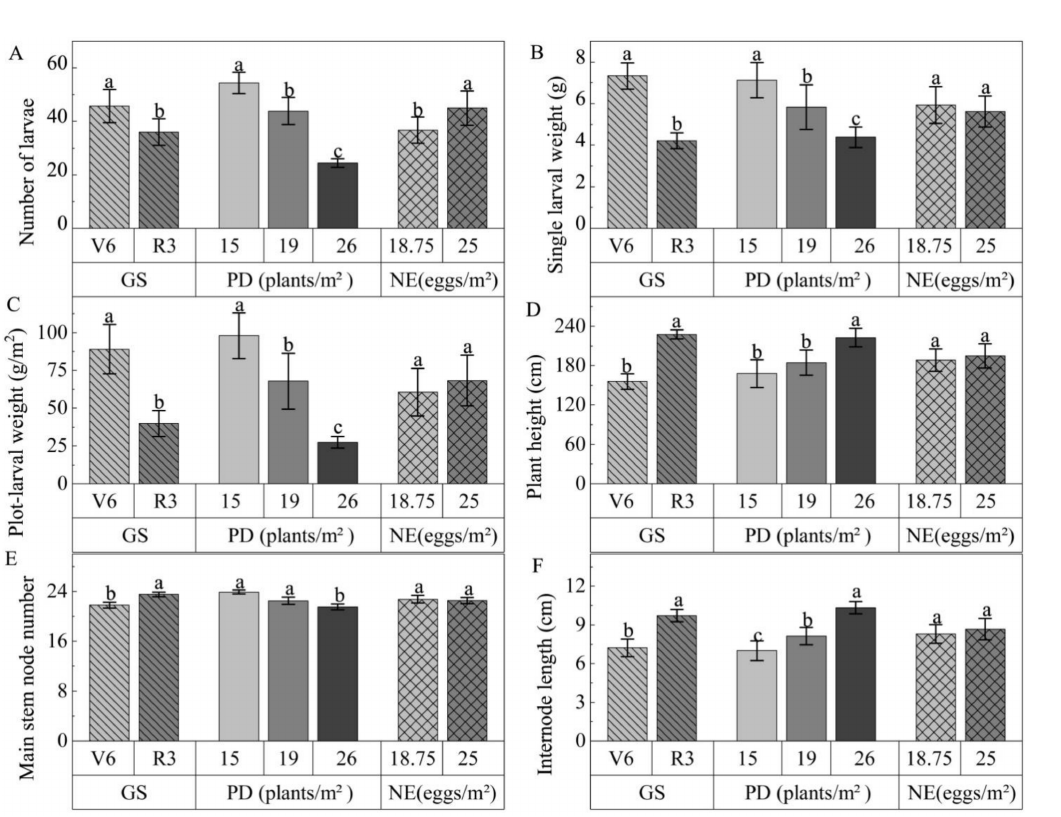
Figure 2. Differences of larval growth indicators and soybean agronomic traits between/among different levels of various factors in spring sowing net houses: ( A ) number of larvae; ( B ) single larval weight; ( C ) plot-larval weight; ( D ) plant height; ( E ) main stem node number; ( F ) internode length; GS, growth stage; PD, planting density; NE, number of eggs inoculated; different lowercase letters between/among levels of rearing factors indicate significant differences of p <